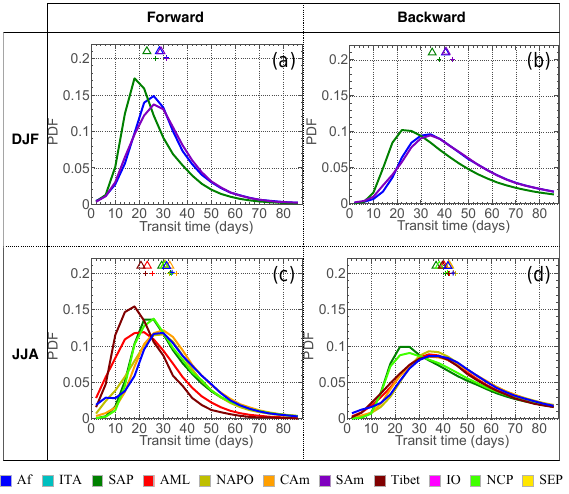
Figure 6. Same as Fig. 4 when the +1km altitude correction of the cloud tops is not applied.